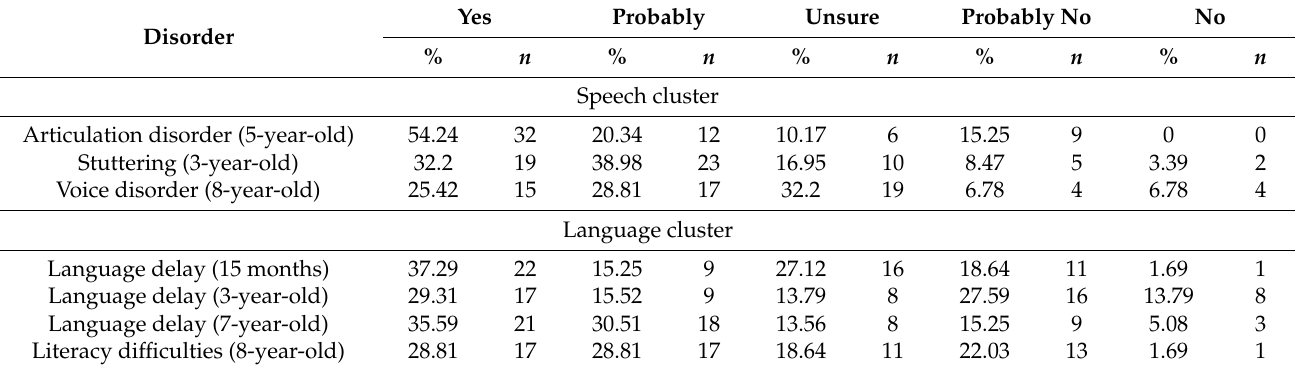
Table 3. Paediatric vignette scores.